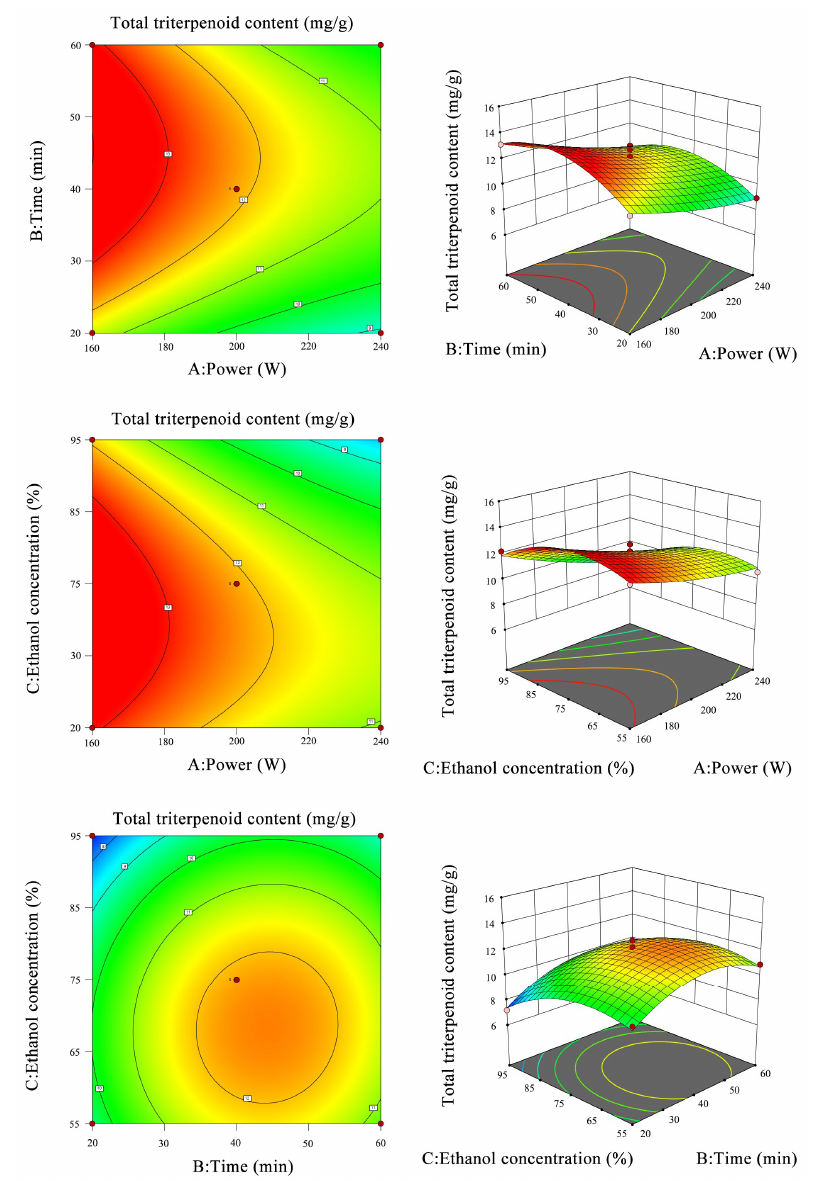
Figure 3. Response surface diagram and contour lines of different factors on total triterpenoid content in loquat peel.